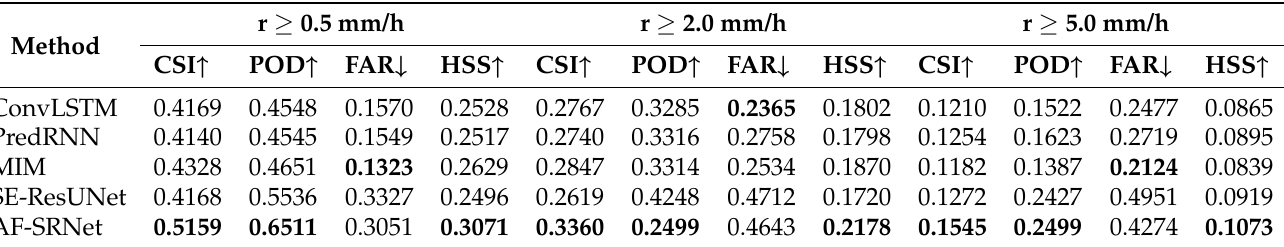
Table 3. Average evaluation results of one frame of precipitation amount nowcasting in the first hour. The best performance is highlighted in bold. ” ↑ ” means that the higher the score, the better, while “ ↓ ” means that the lower the score, the